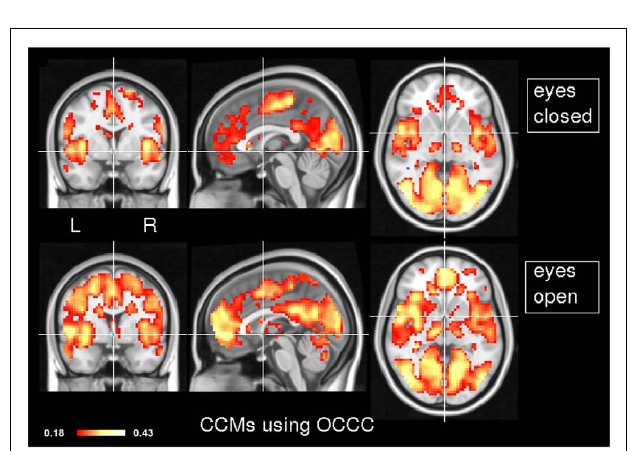
FIGURE 2 | Inter-subject CCM using OCCC. As in Figure 1 , CCM has been calculated for eyes-closed (top) and eyes-open (bottom), n = 7 subjects in each condition. MNI coordinates of slice positions are (0, 0, 0). For comparison, the concordance measure was OCCC.